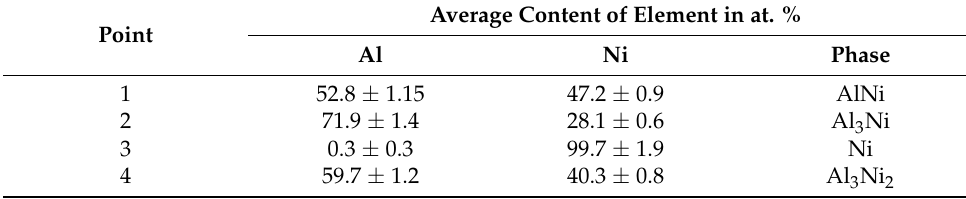
Figure 4. Microstructures of explosively welded Ni201/A1050 clad manufactured at V d = 2800 m/s: overall view of wavy interface ( a ), representative part of the melted region of individual wave with its microstructure imaged by backscattered electrons contrast in SEM ( b ) together with the magnification of the microstructure details ( c , d ). Results of chemical analysis marked with points 1 to 4 are collected in Table 4. Table 4. The chemical compositions obtained by SEM/EDS point analysis located in the regions marked with numbers 1–4 in Figure